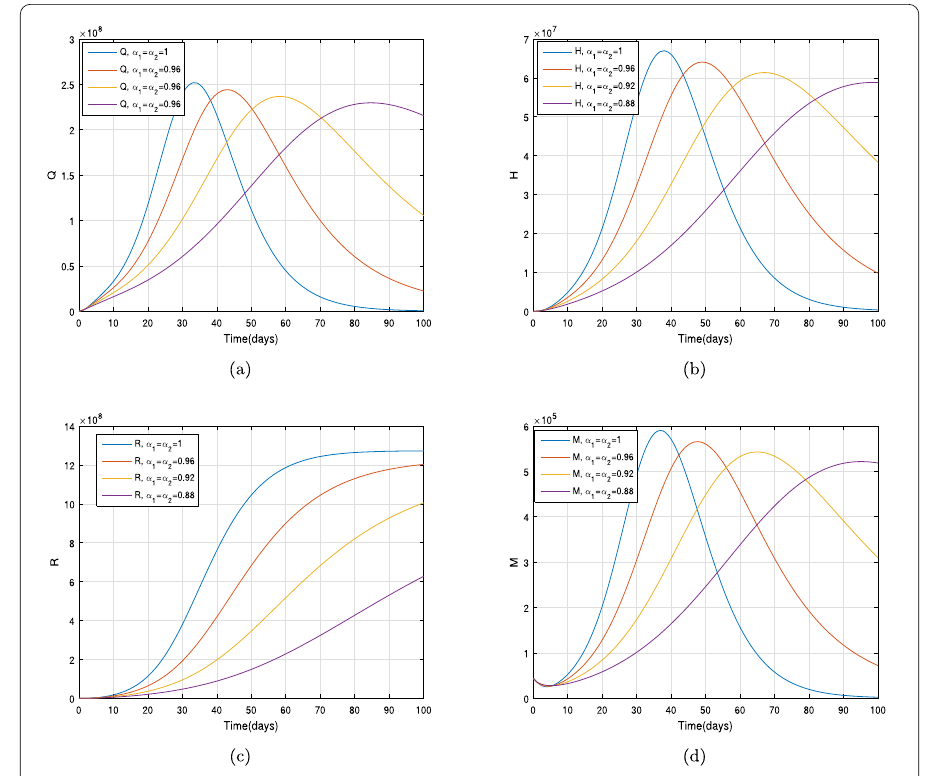
Figure 14 The dynamics of the model variables for α 1 = α 2 = 1,0.96,0.92,0.88, subfigures (a)–(d) respectively represent the quarantined, hospitalized, recovered, and contaminated environment